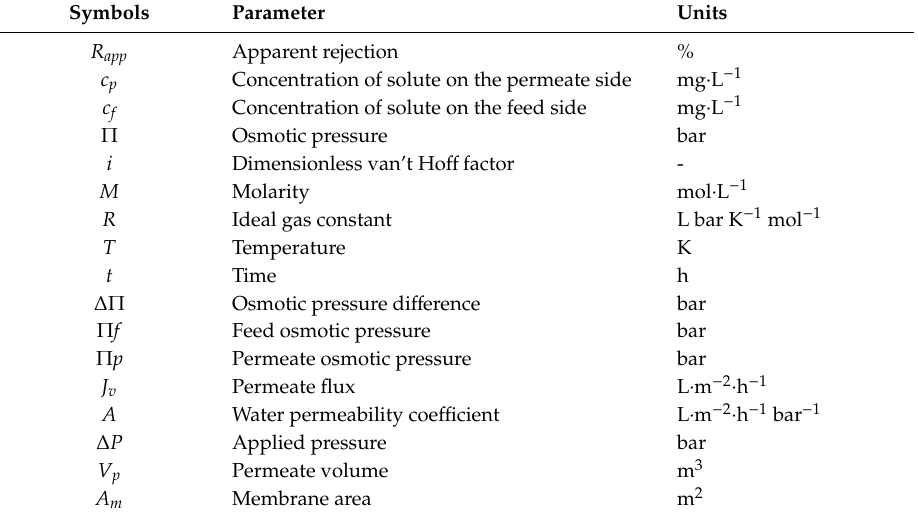
Figure A2. ( a ) Graph of rejection as a function of the cross flow rate (Operating Conditions: 8000 mg/L MgSO 4 , pH 7, 25 °C, and 25 bar). ( b ) Graph of salt passage as a function of cross flow rate (Operating Conditions: 8000 mg/L MgSO 4 , pH 7, 25 °C, and 25 bar).